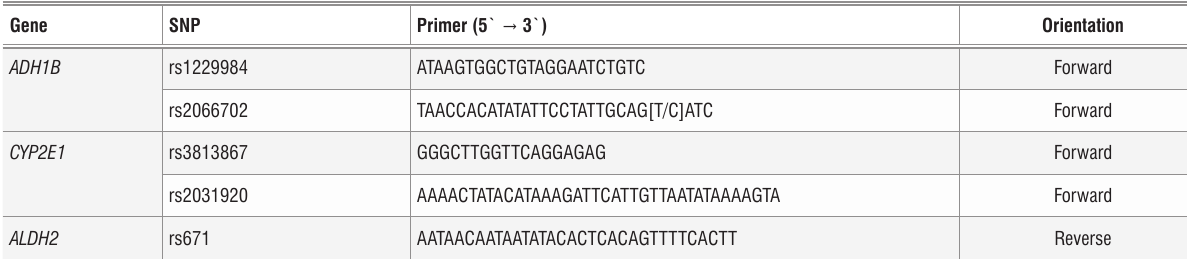
Internal primers used for SNaPshot